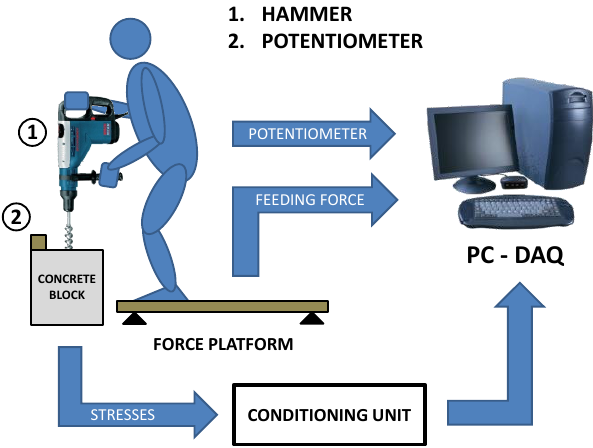
Figure 2. Scheme of the measurement setup.